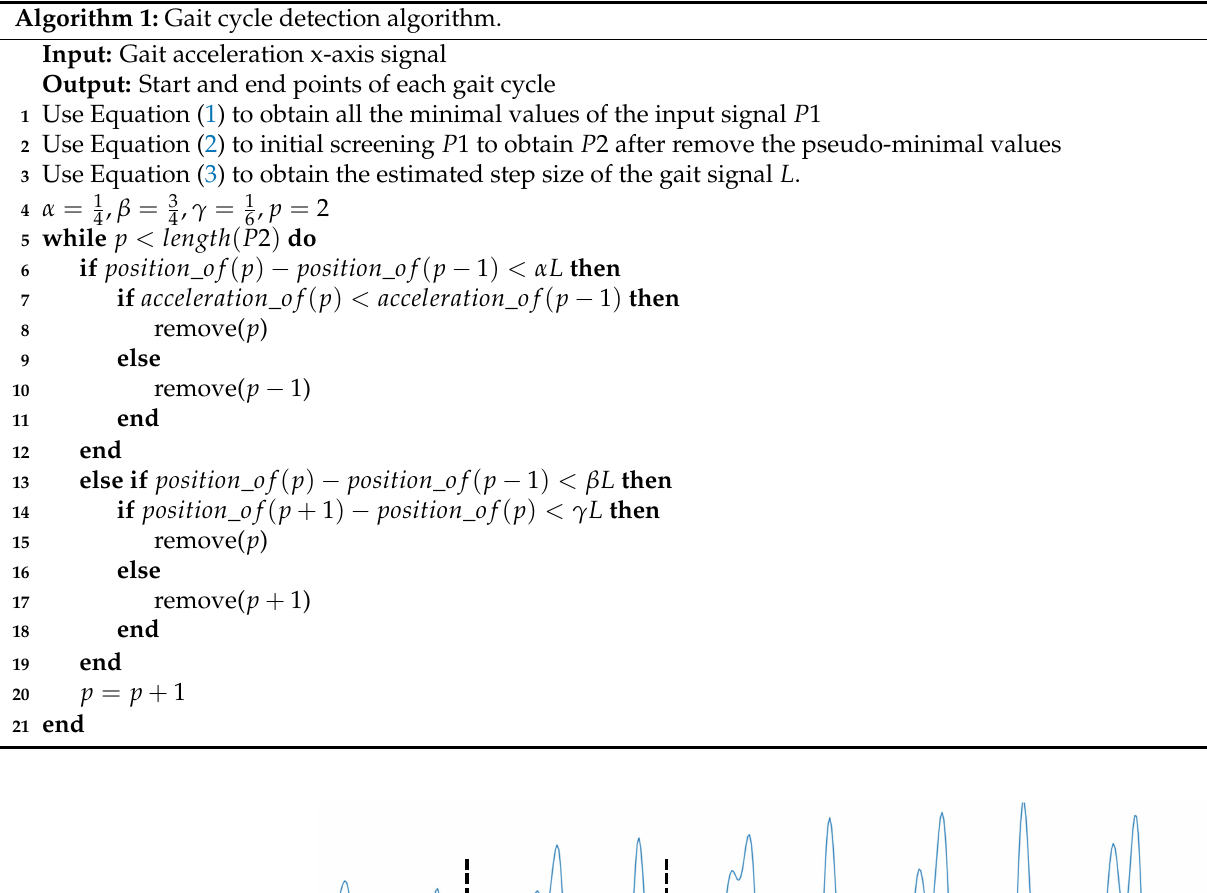
Algorithm 1: Gait cycle detection algorithm.